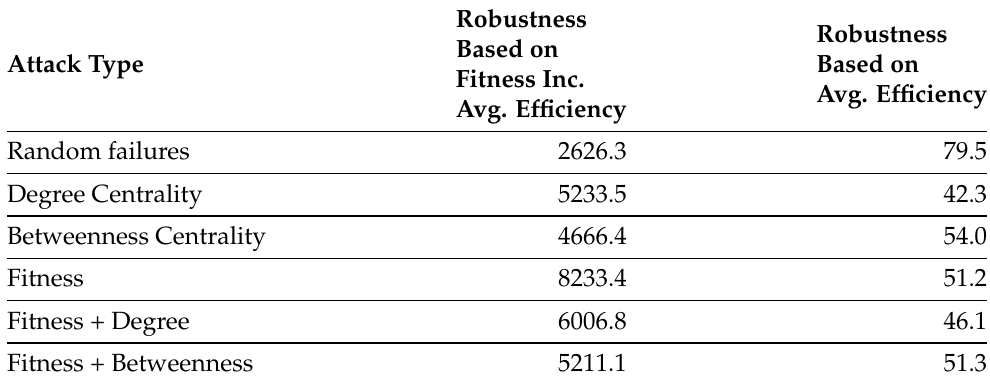
Table 10. Robustness analysis of the CO 2 exchange network, N = 112.